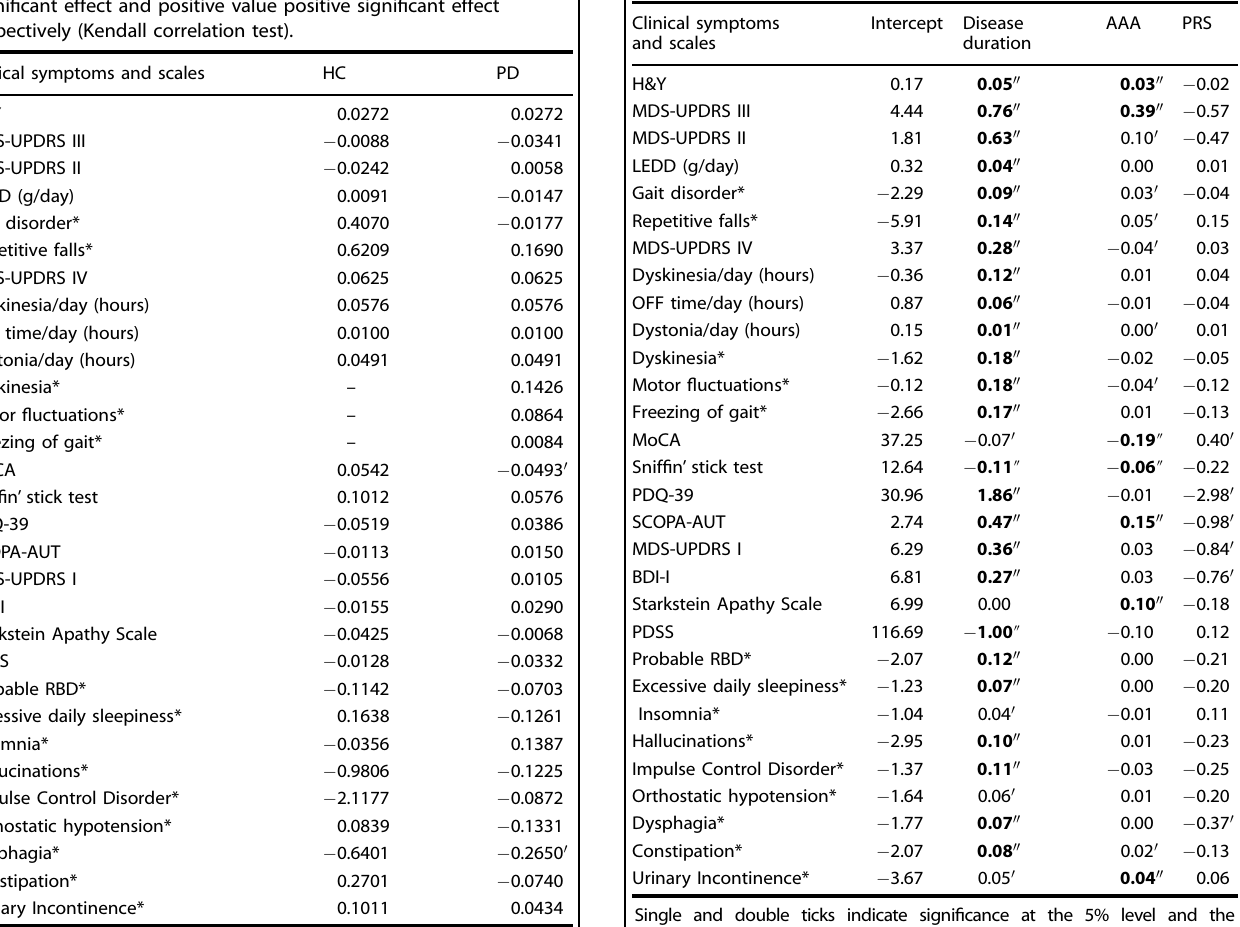
Table 7. Multiple regression model with coef fi cients shown from linear regression of numerical outcome and from logistic regression of binary outcome on disease duration, age at assessment (AAA) and polygenic risk score (PRS) in PD group.